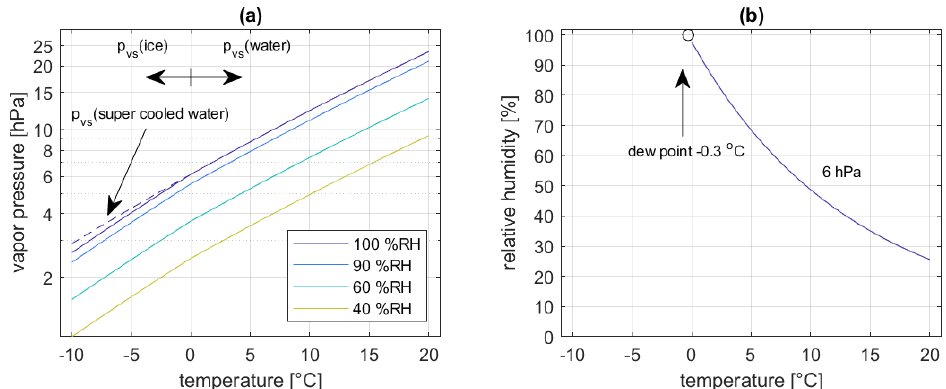
Figure 3. ( a ) The relationship between vapor pressure, temperature, and relative humidity above and below 0 °C (above water and above ice, respectively) [27]; ( b ) the relationship between temperature and relative humidity at a constant vapor pressure.